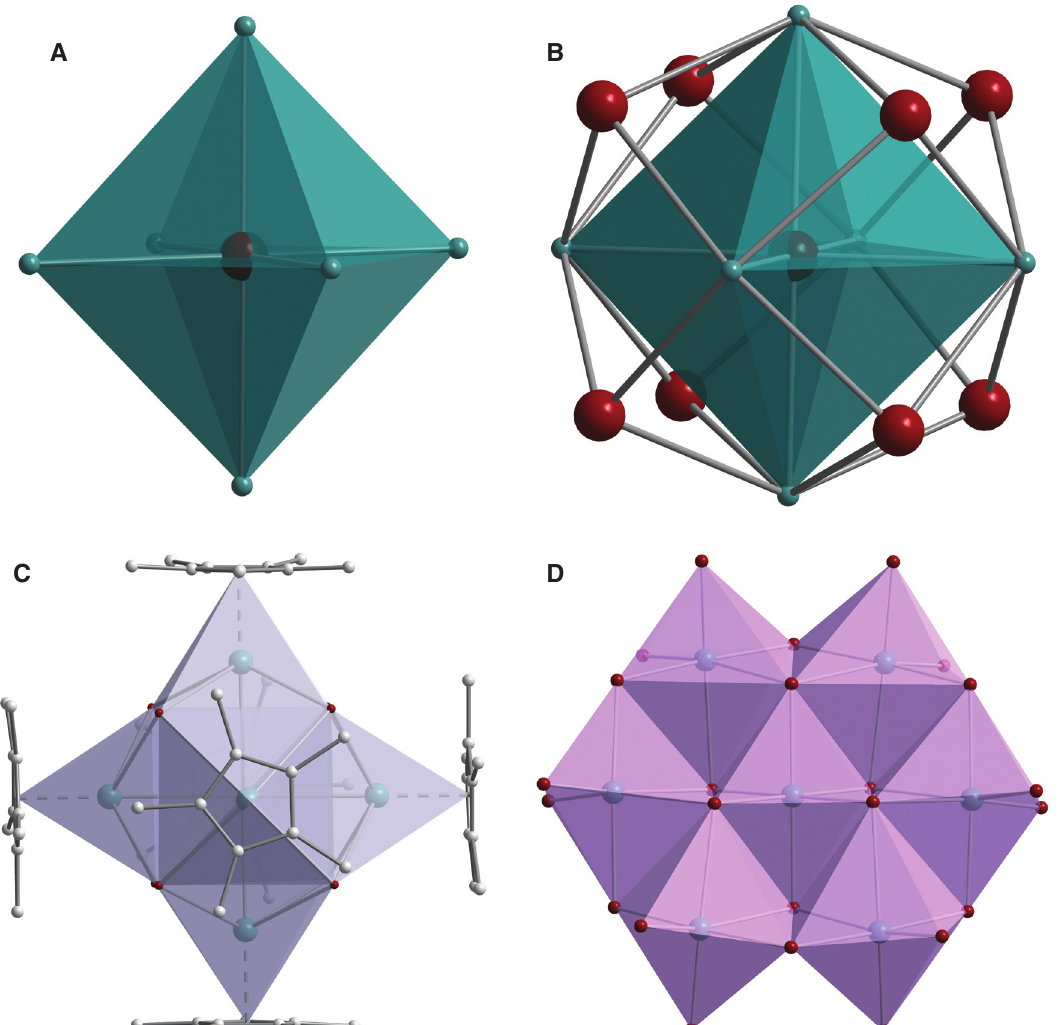
Cp* Br ][Bi Br ] ( 1 ). 6 6 9 7 24 } cage; (B) an interstitial Br–containing Bi octahedron capped by μ 6 6 - and μ -bridging 2 3